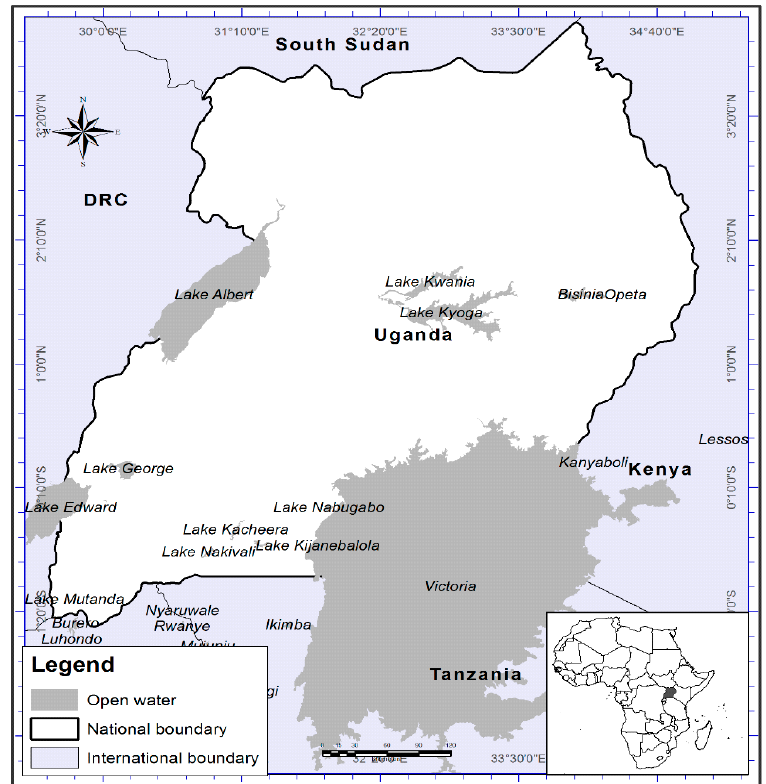
Figure 1. Location of the study area in Africa.